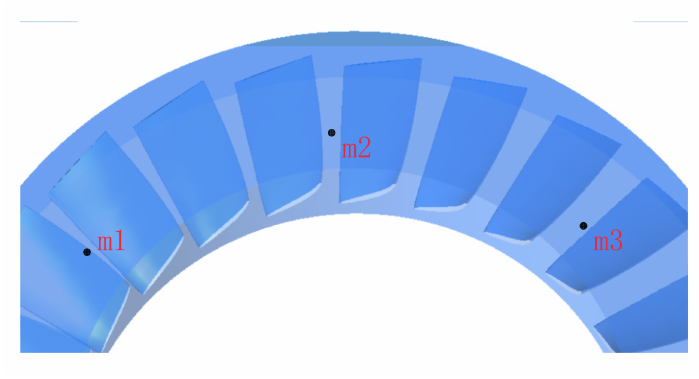
Figure 5. The distribution of monitoring